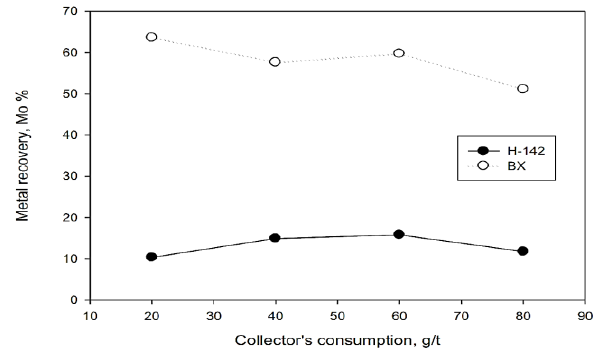
Figure 2. Dependence of H-142 collector’s consumption on Molybdenum metal recovery (%)